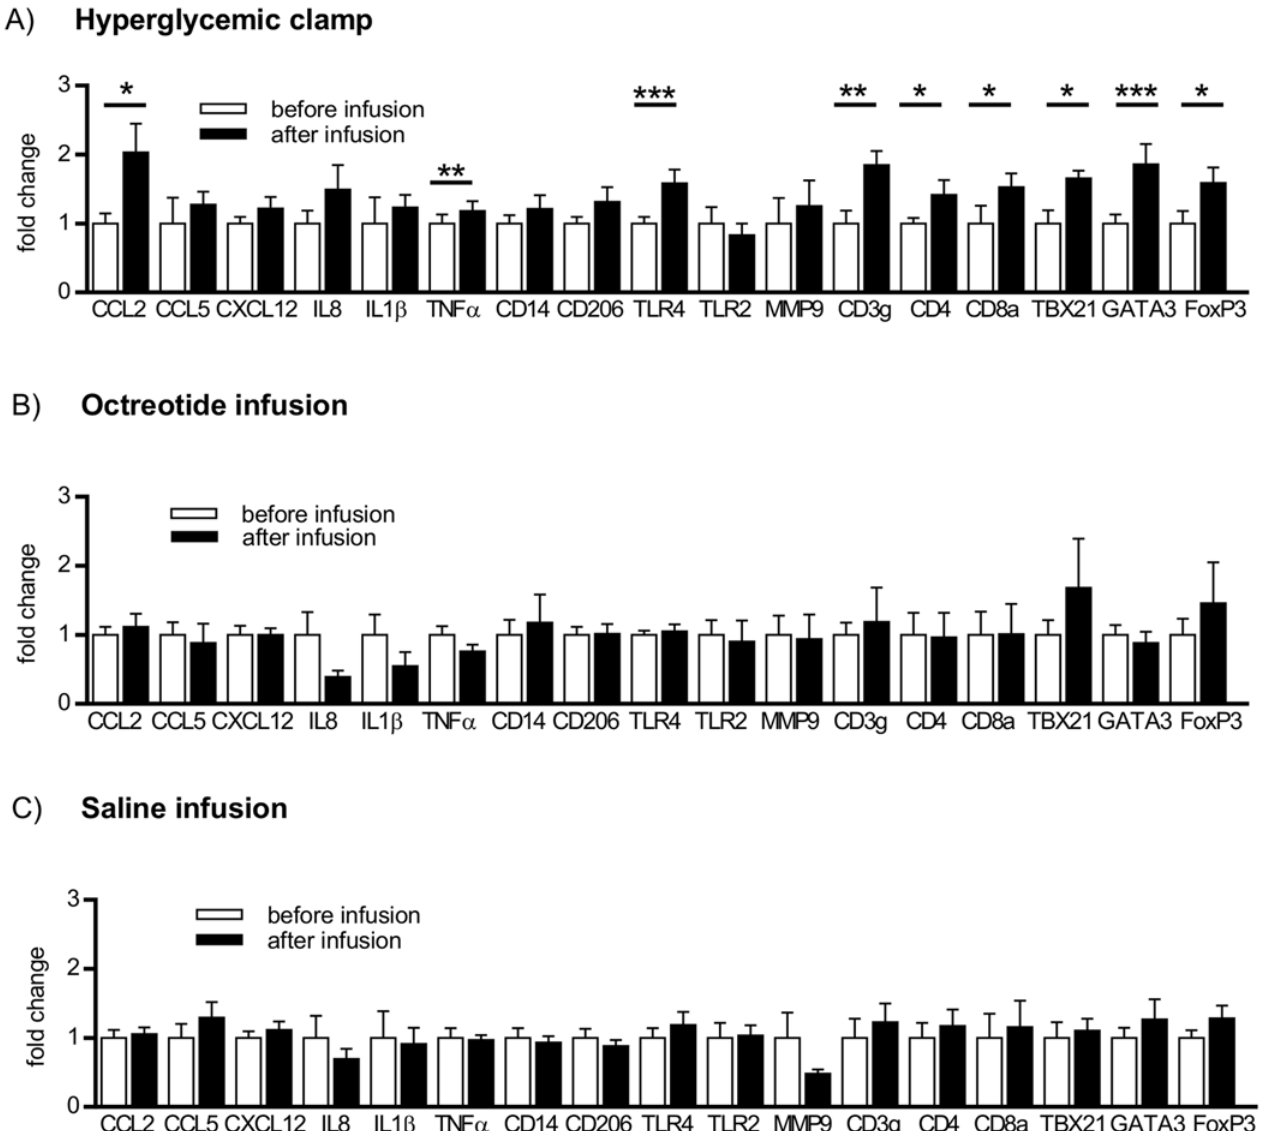
Fig 2. Effect of hyperglycemic clamp (A), octreotide infusion (B), and saline infusion (C) on mRNA levels of selected immunity-related genes in subcutaneous abdominal adipose tissue of obese women. White bars- before infusion, black bars- after infusion. Data are presented as mean fold change ± SEM. Relative mRNA levels are normalized to geometrical mean of 2 housekeeping genes 18S and GUSB, n = 6 (hyperglycemic clamp), n = 9 (octreotide and saline infusion), * p < 0.05; ** p < 0.01; *** p < 0.001: before vs after clamp.